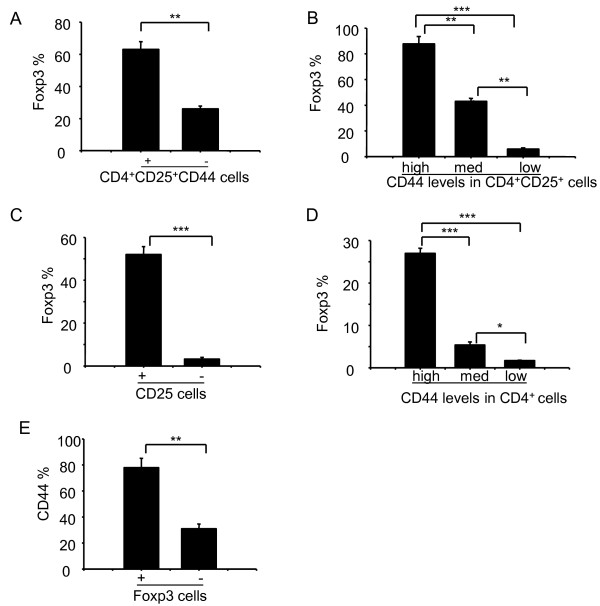
Foxp3 expression in different subsets of thymocytes. Thymocytes were stained with antibodies against CD4 (PE-Cy7), CD8 (FITC), CD44 (PE), CD25 (APC-Alexa Fluor755), and Foxp3 (PE-Cy5). CD4-CD8- DN, CD4+CD8- SP, CD4-CD8+ SP, and CD4+CD8+ DP thymocytes were gated for subsequent analyses. (A) Foxp3 expression (%) in CD4+CD25+ cells that was either positive or negative for CD44. (B) Foxp3 expression (%) in CD4+CD25+ cells that expressed high, medium, or low levels of CD44. (C) Foxp3 expression (%) in CD4+ cells that was either positive or negative for CD25. (D) Foxp3 expression (%) in CD4+ cells that expressed high, medium, or low levels of CD44. (E) CD44 expression (%) in CD4+ cells that was either positive or negative for Foxp3. Panels A to E show representative results with mean ± S.D. from three independent experiments (* p < 0.05, ** p < 0.01, *** p < 0.001).